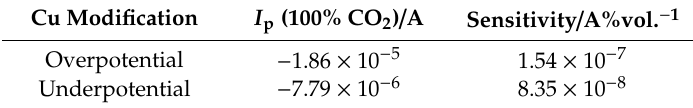
Table 3. Analytical parameters obtained for CO 2 reduction in [C 4 mpyrr] [NTf 2 ]: reduction peak current